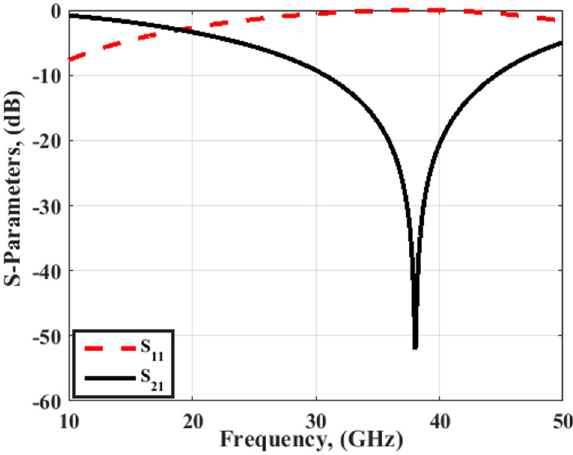
Figure 16. The FSS unit cell S-parameters results.